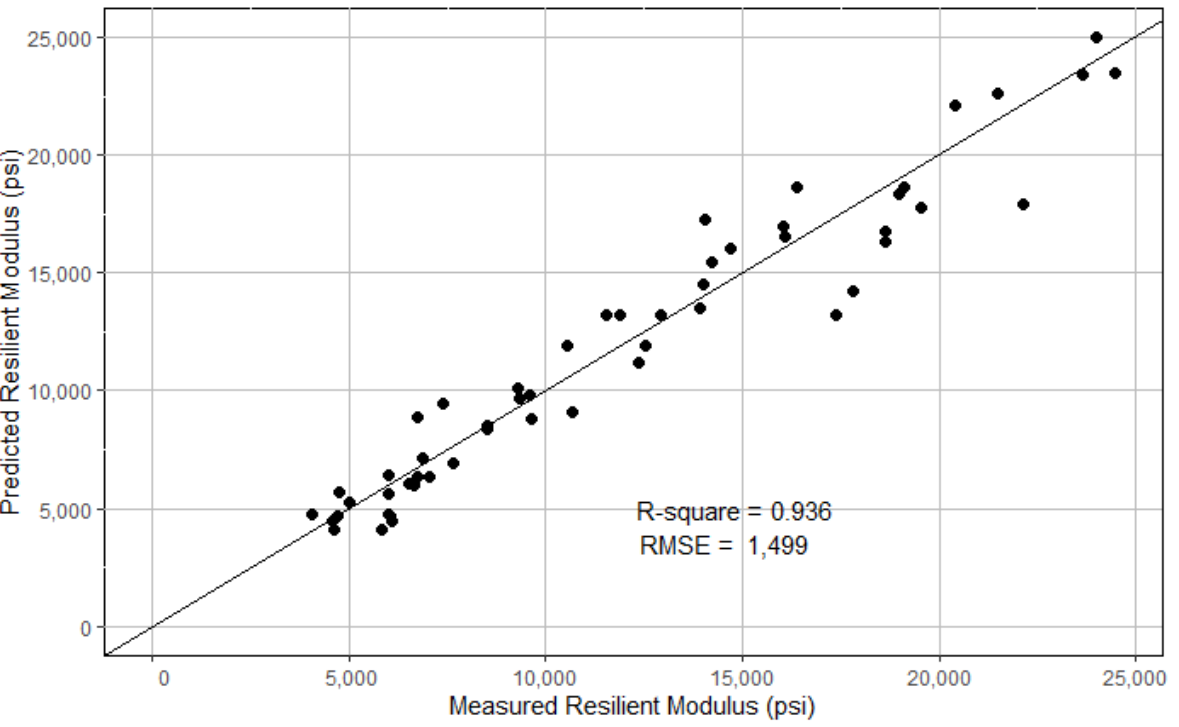
Figure 7. Predicted M R versus measured M R on testing dataset (the RF model).